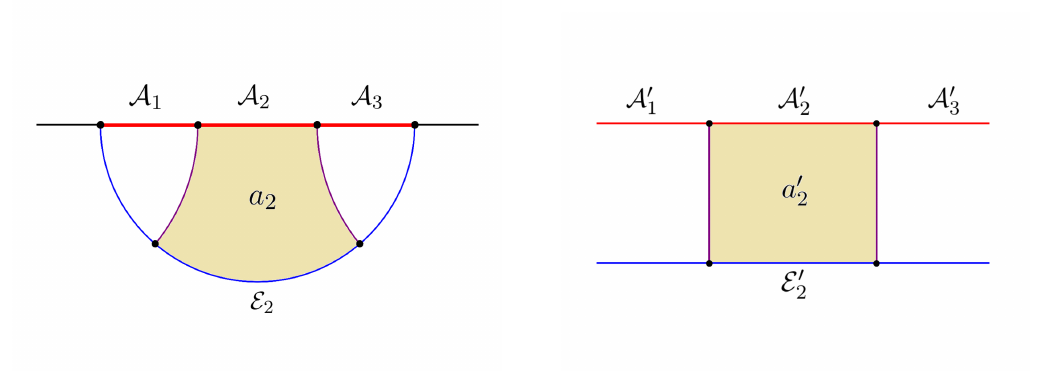
Figure 5: The homology surface a at a time slice is mapped to the time slice of the Rindler bulk under the Rindler transformation. γ along the r direction. The bulk region a is the projection region of A (cid:48)